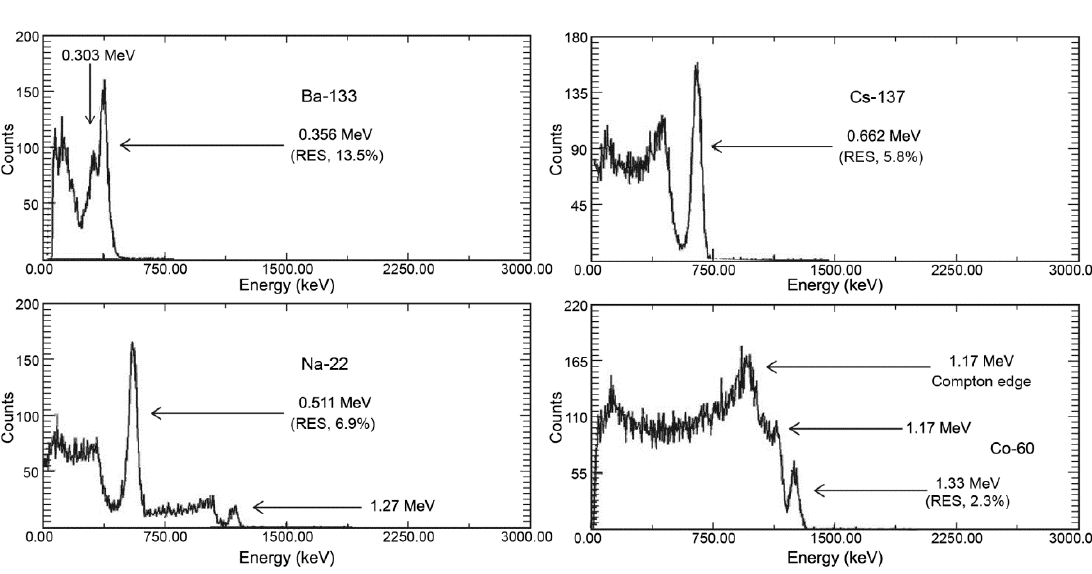
Figure 3. Measured energy spectra for 133 Ba (0.356 MeV), 22 Na (0.511 MeV), 137 Cs (0.662 MeV), and 60 Co (1.33 MeV).